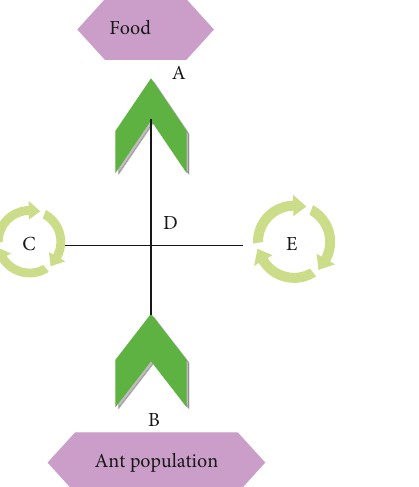
Figure 1: The ant colony “double-bridge”